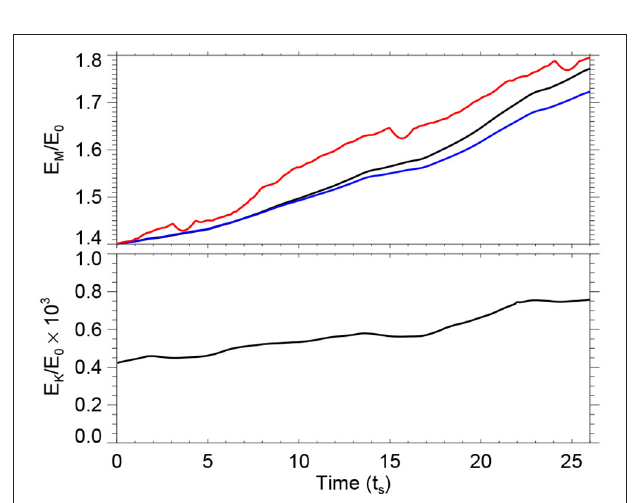
FIGURE 6 | Magnetic energy (Top) and kinetic energy (Bottom) evolution of the MHD system as driven by the photospheric flows. The black lines represent the values of the volume-integrated energies. The blue line in the top panel shows the time integration of the total Poynting flux on the bottom surface from the simulation. The red line shows the accumulated magnetic energy from directly the observation data, i.e., the same one shown in Figure 4 .